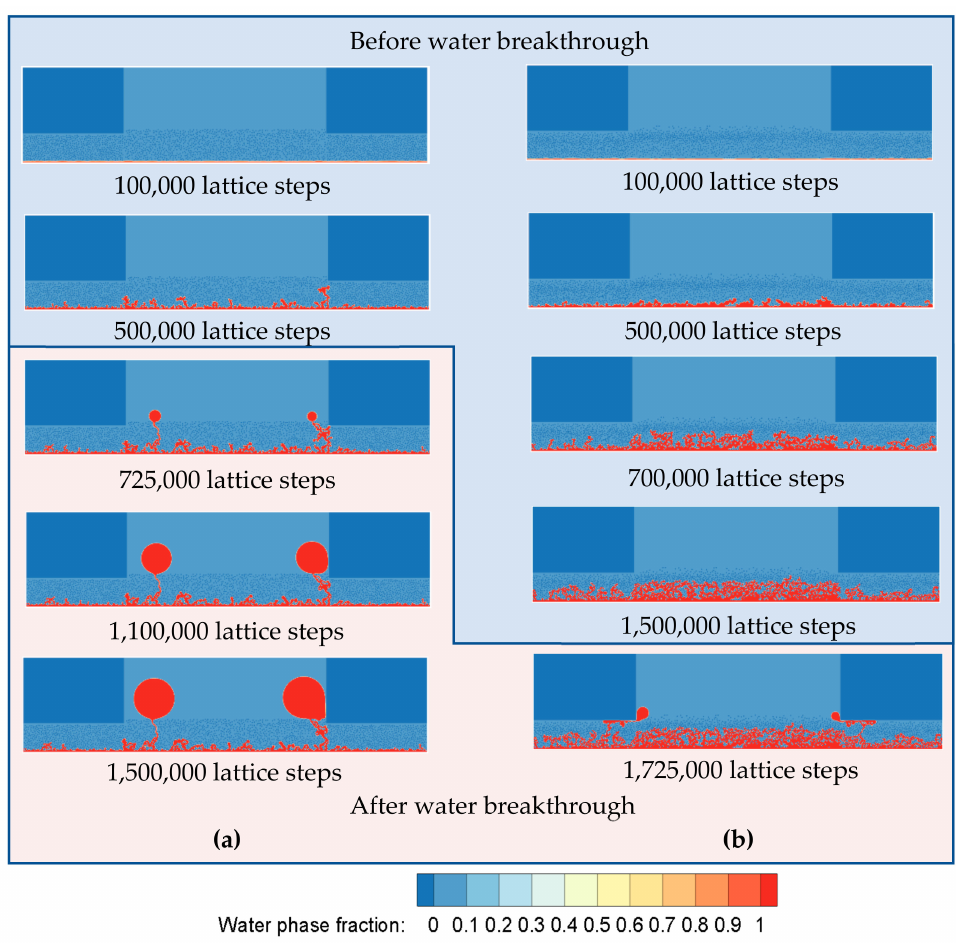
Figure 3. Water saturation of ( a ) ideal GDL (left) and ( b ) real GDL